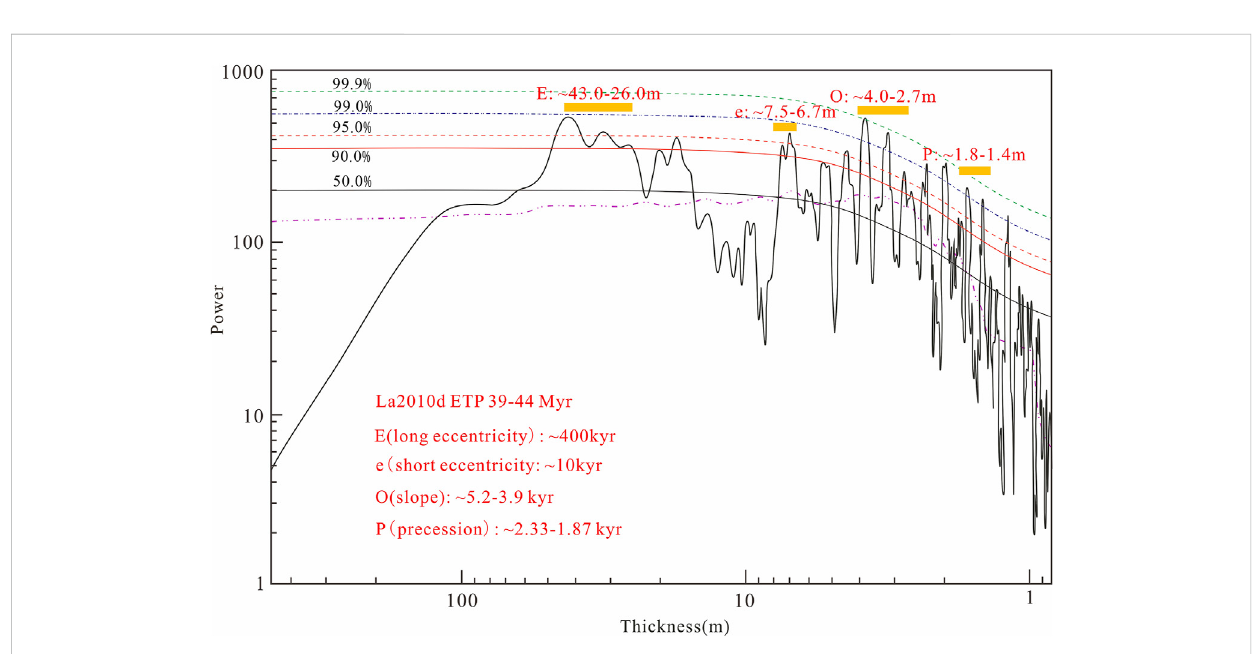
FIGURE 7 Spectral analysis of the astronomical